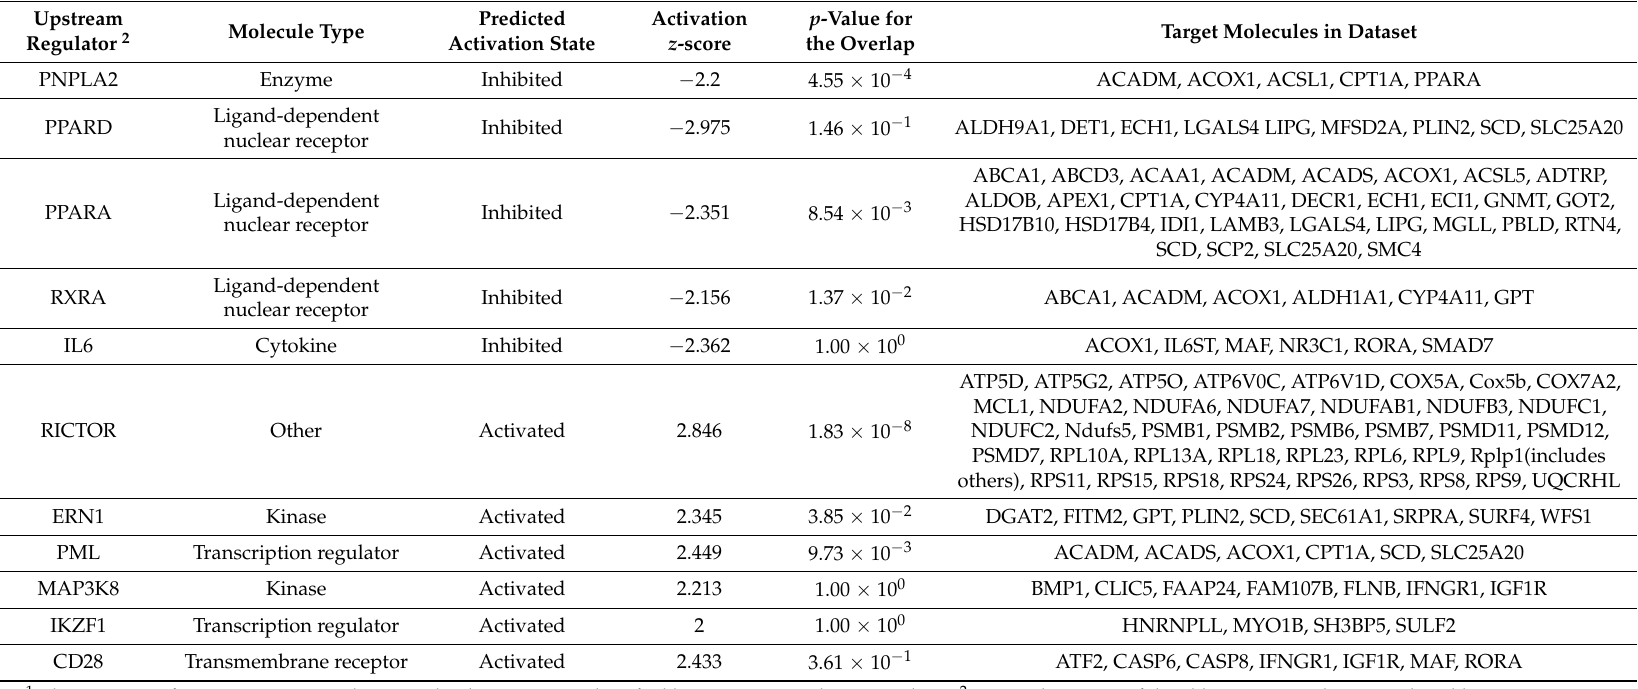
Table 2. Upstream regulators predicted to be altered by astaxanthin in mice with nonalcoholic steatohepatitis 1